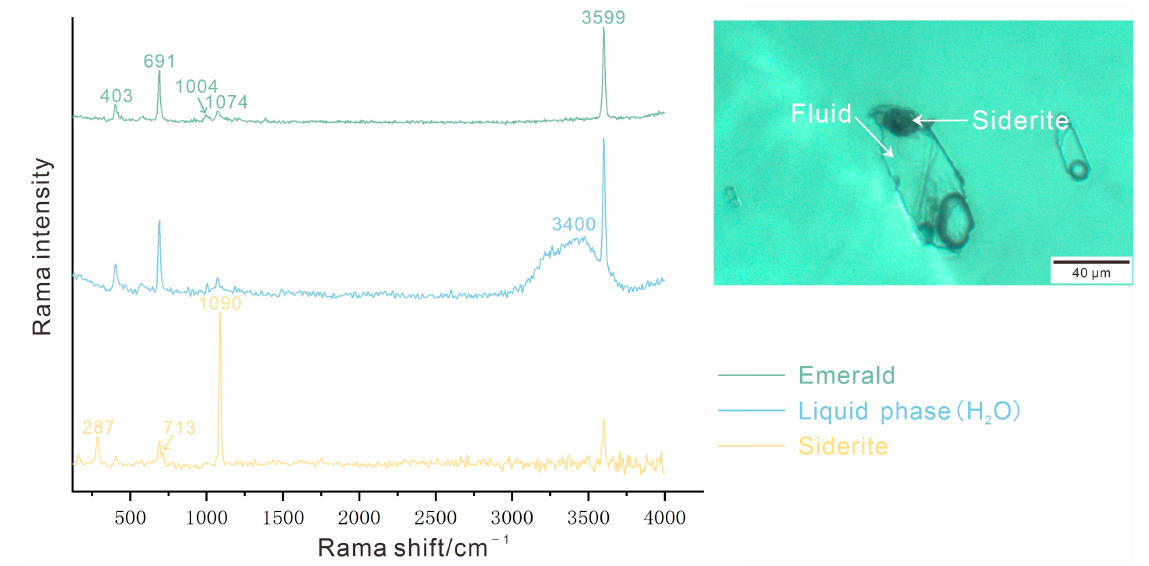
Figure 12. This hexagonal three-phase inclusion in a Kamakanga emerald (KAM-44) clearly displays a gas bubble and a black mineral. Raman spectroscopy was used to identify the host emerald (green), the liquid phase (blue), and the siderite crystal (yellow). The spectra are stacked for clarity.